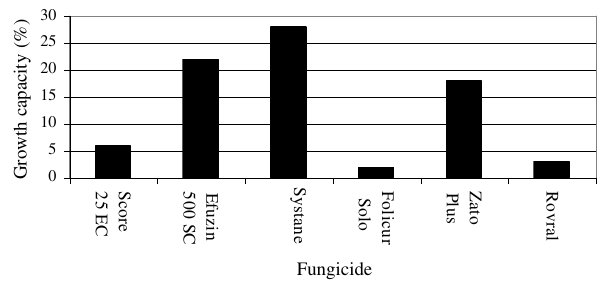
Figure 4. Percent growth capacity of Monilinia laxa for 6 fungicides (approved in integrated production) admended on PDA plates at 0.5 × dosage recommended by the manufacturer (LSD